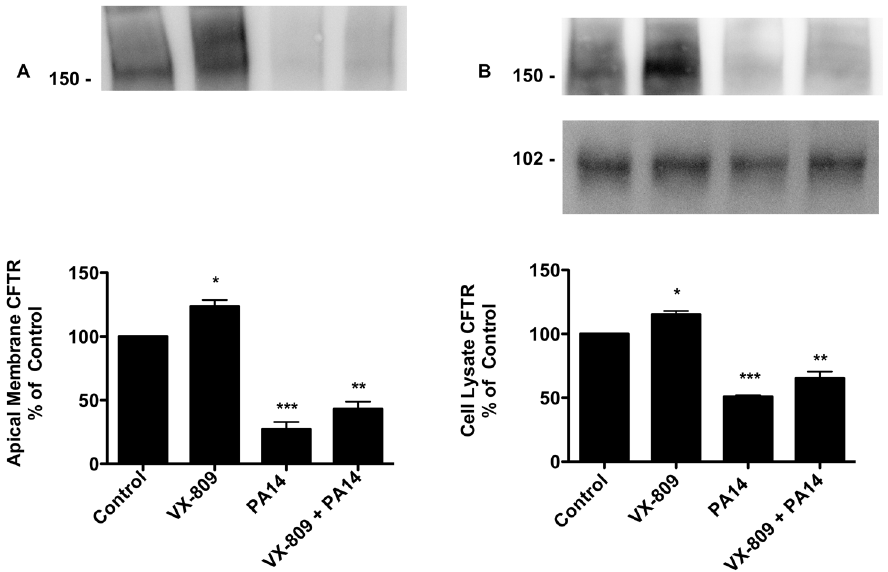
Fig 6. Analysis of apical CFTR in the presence of VX-809 alone and in combination with P . aeruginosa . (A) Western blot of apical membrane F508del-CFTR in CFBE cells treated with vehicle (Control), VX-809 (3 μ M) alone, PA14 alone, or VX-809 (3 μ M) + PA14. Na + -K + -ATPase is a loading control. * P < 0.05 versus all other groups. N = 4/group. ** P < 0.05 versus VX-809 alone, *** P < 0.05 versus Control. N = 4/group. (B) Top: Representative western blot of F508del-CFTR in cell lysates of CFBE cells treated with vehicle (Control), VX- 809 (3 μ M) alone, PA14 alone, or VX-809 (3 μ M) + PA14. Bottom: Representative western blot of Na + -K + - ATPase (gel loading control) in cell lysates of CFBE cells treated with vehicle (Control), VX-809 (3 μ M) alone, PA14 alone, or VX-809 (3 μ M) + PA14 * P < 0.05 versus all other groups. ** P < 0.05 versus VX-809 alone, *** P < 0.05 versus Control. N = 4/group. All samples run on the same gel but cut for presentation. N = 4/